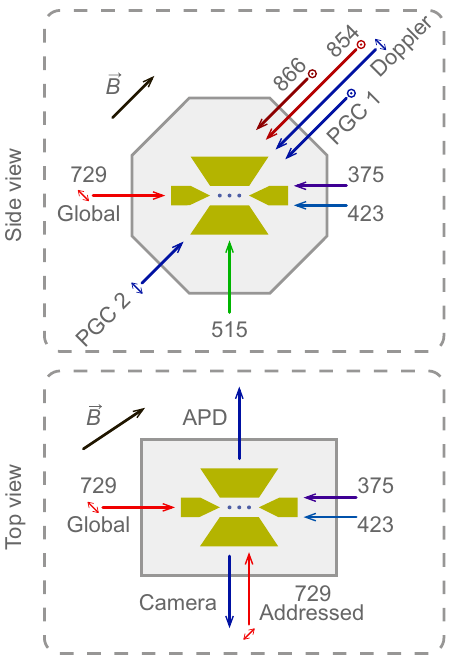
FIG. 8. Geometric arrangement of beam delivery; beam polar- ization indicated where required. The Doppler cooling beam, the repumping and quenching beams, as well as PGC beams enter the chamber at 45 ◦ to the trap axis. The collective 729 nm beam is delivered through a hole in the trap endcap. Photoionization beams enter through a hole in the opposing endcap. The medium- NA port is used for collective readout of the whole ion chain with an APD. The high-NA access port is used for single-ion addressing and readout with a camera.